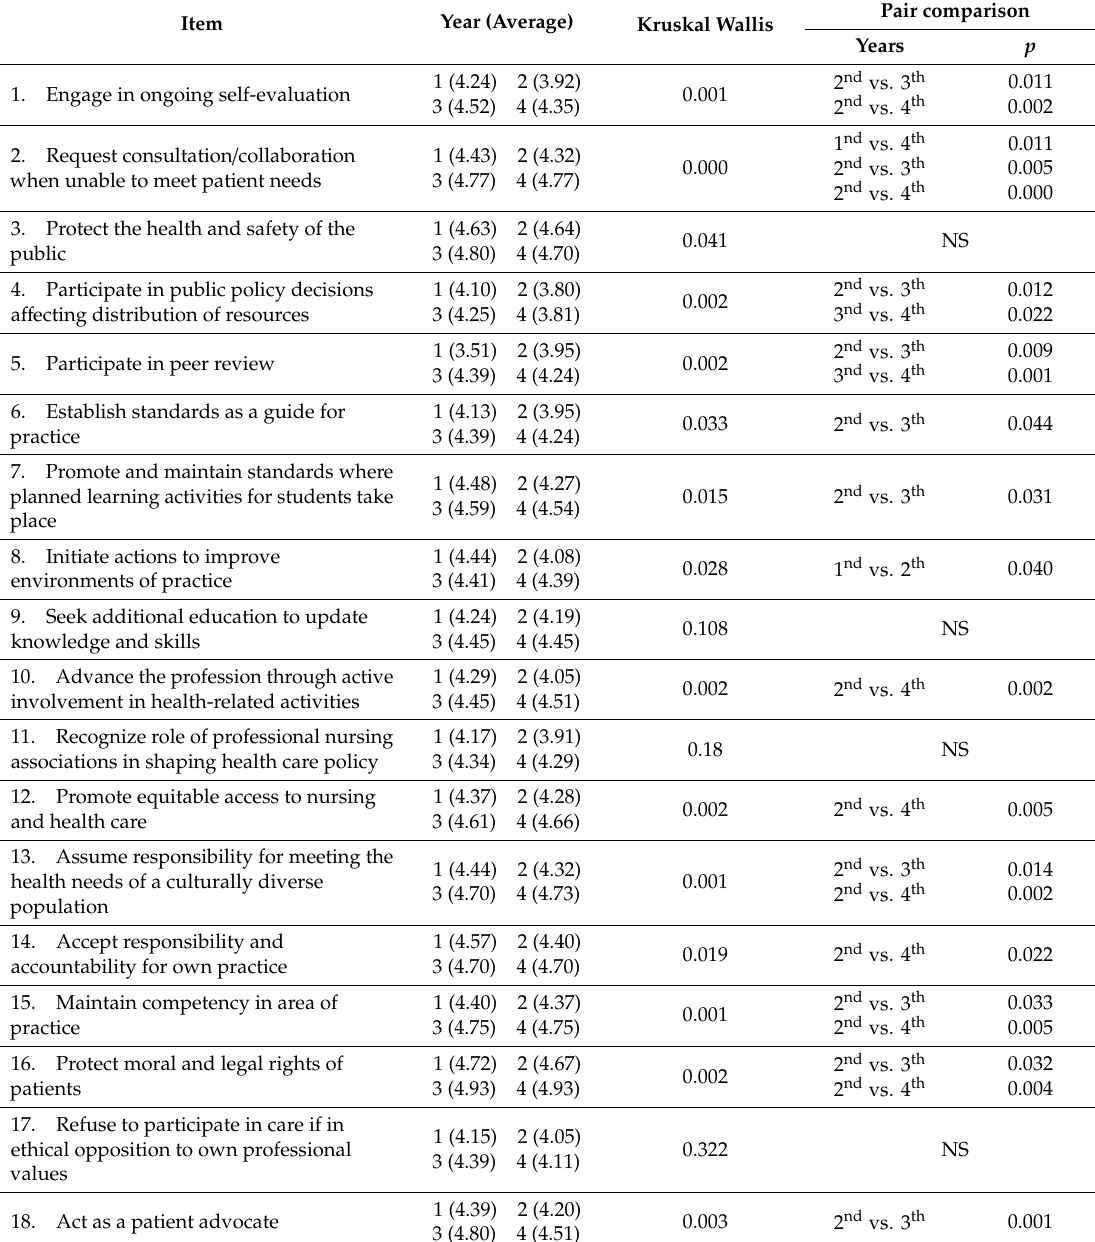
Table 3. Pair comparison of EVPS scale items in relation to academic